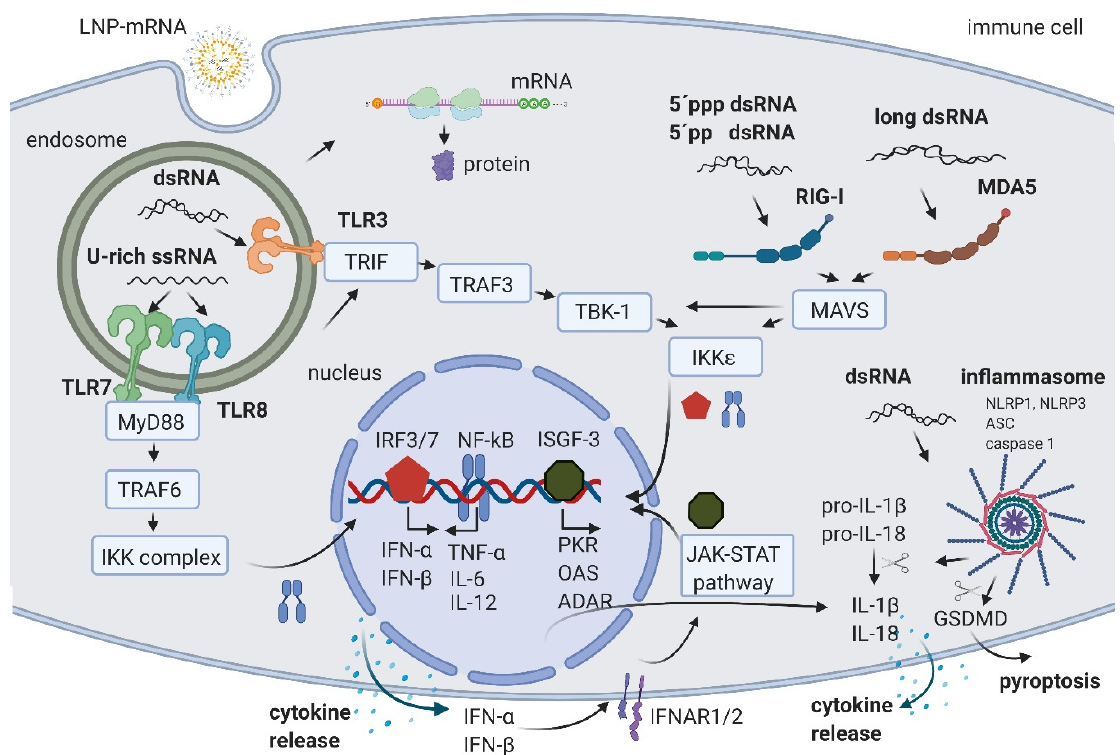
Figure 1. Schematic of RNA-induced immune activation. LNP-mRNA is endocytosed by cell-specific mechanisms. Small fractions of mRNA and byproducts of IVT reaction are released to cytoplasm by endosomal escape. In the cytoplasm, mRNA is translated by cellular machinery. In endosomes, U-rich ssRNA is sensed by TLR7 and TLR8, and dsRNA is detected by TLR3. The activation signal is transferred through the signal transduction cascade to the nucleus where the transcription factors NF-kB, IRF3, and IRF7 promote the production of cytokines. The released IFN- α and IFN- β are recognized by their receptor IFNAR, leading to the activation of the JAK-STAT pathway and the formation of ISGF-3, which activates the transcription of multiple hundreds of genes including PKR, OAS, and ADAR. In the cytoplasm, 5 ′ ppp dsRNA and 5 ′ pp dsRNA are recognized by RIG-I, and long dsRNA by MDA5. Both pathways lead to the additional increase in NF-kB, IRF3, and IRF7. Moreover, dsRNA can also activate the inflammasome through NLRP1 or NLRP3, leading to the cleavage of pro-IL-1 β and pro-IL-18 by caspase 1 and IL-1 β and IL-18 release, or a GSDMD cleavage followed by pyroptosis. Created with BioRender.com.